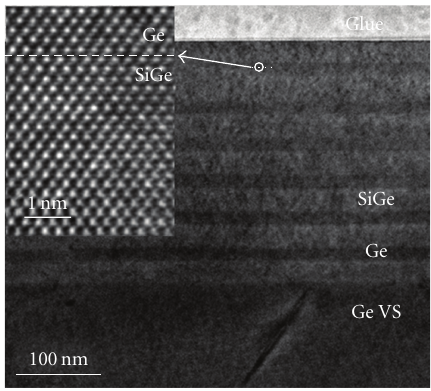
Figure 10: HRTEM images of sample with Ge/SiGe MQW on Ge- on-Si